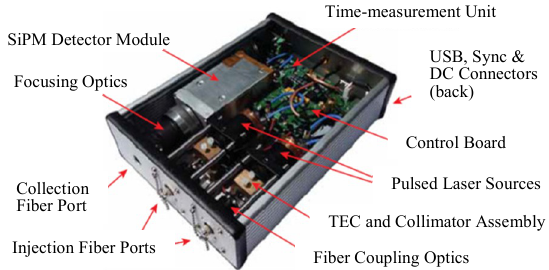
Figure 13. Photo of the compact dual-wavelength TD-NIRS system developed by the group in Italy. Modified from Reference [56].